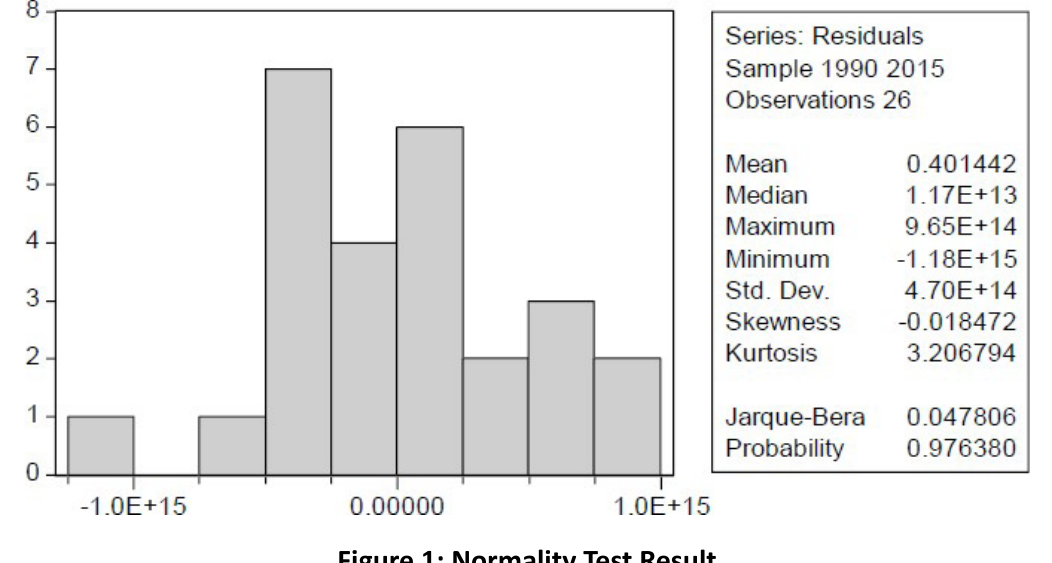
Figure 1: Normality Test